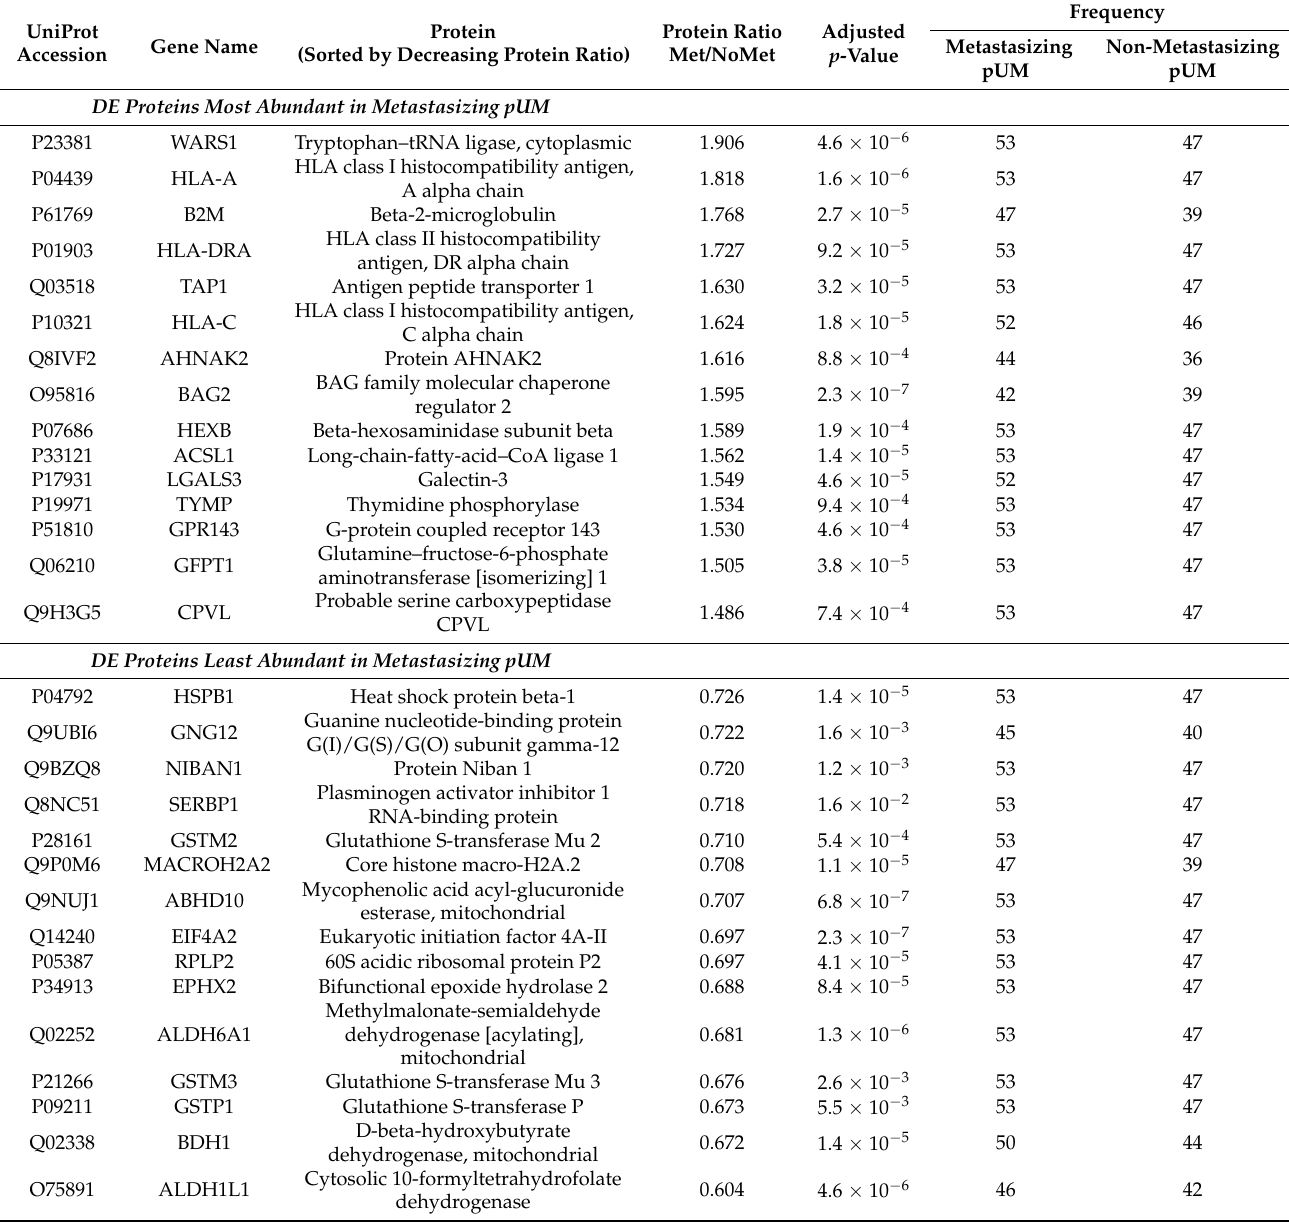
Table 2. Differentially Expressed pUM